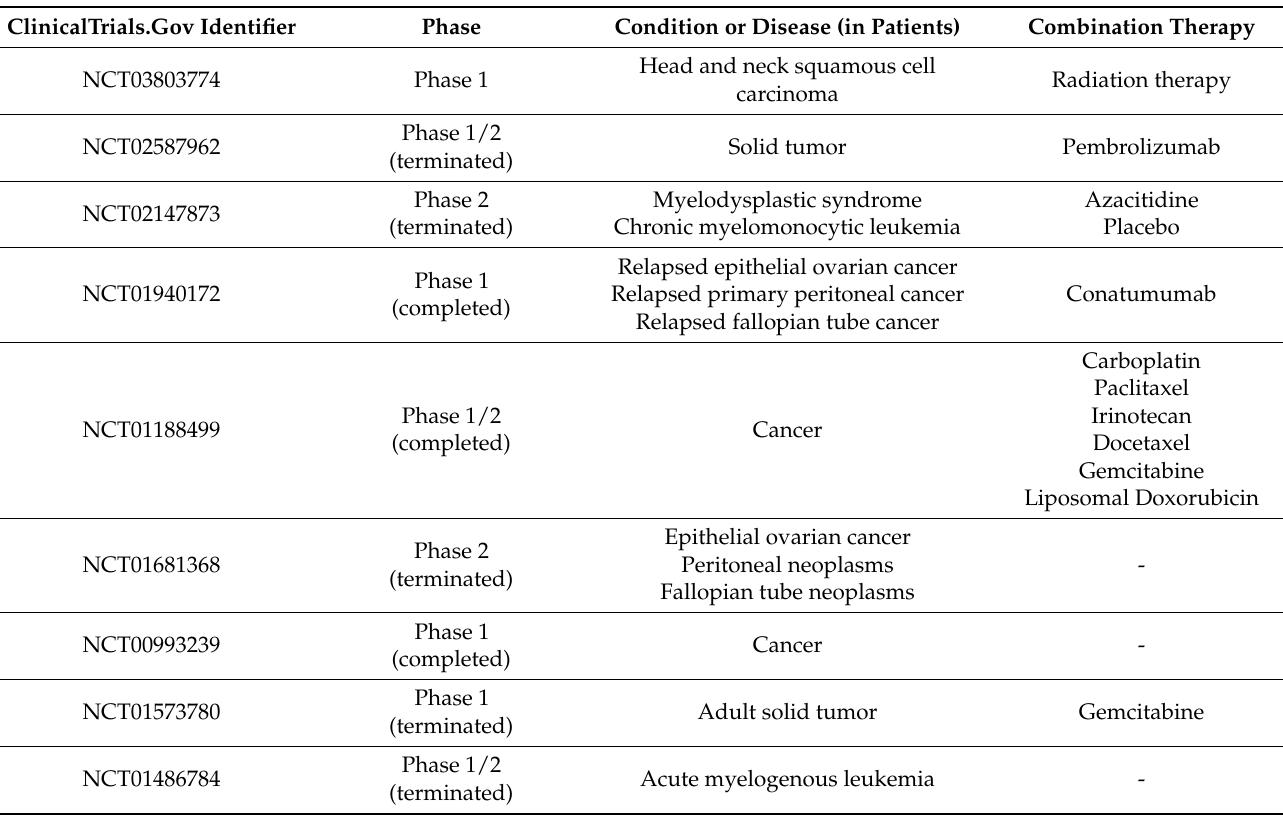
Table 2. Clinical status of birinapant (TL32711) for cancer